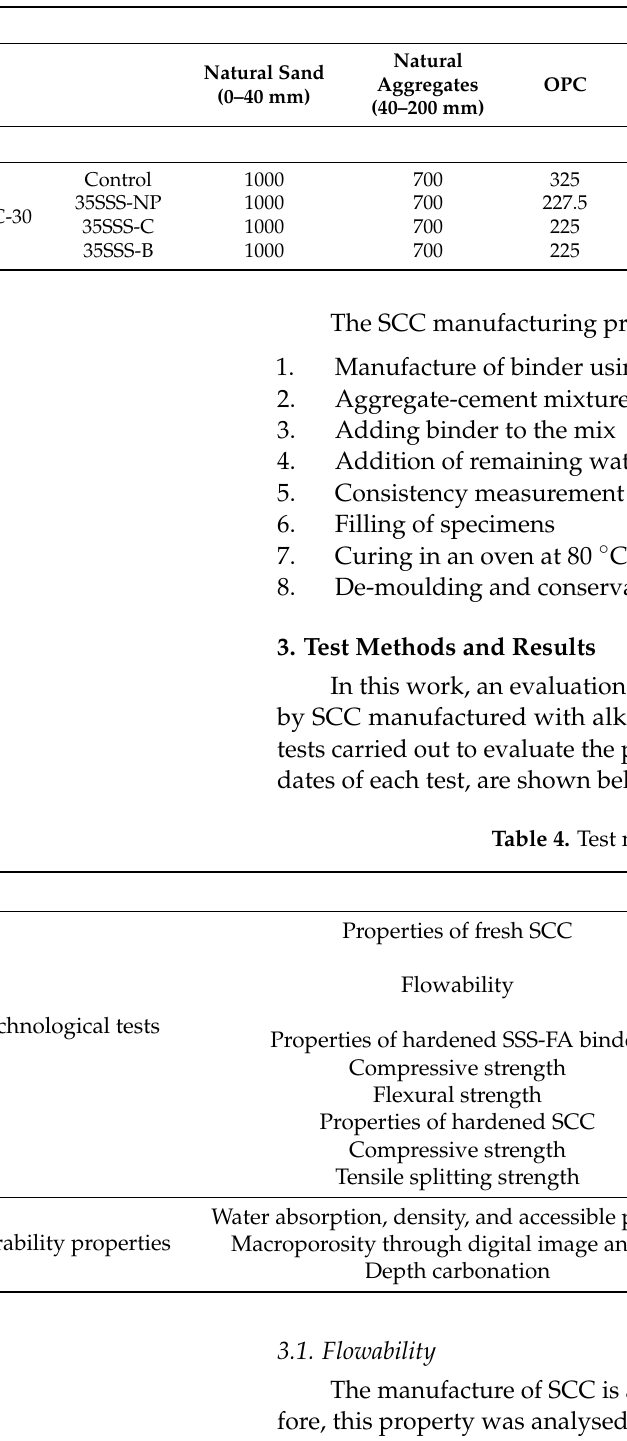
Table 3. Mix proportion of alkali-activated SCC (kg/m 3 ).